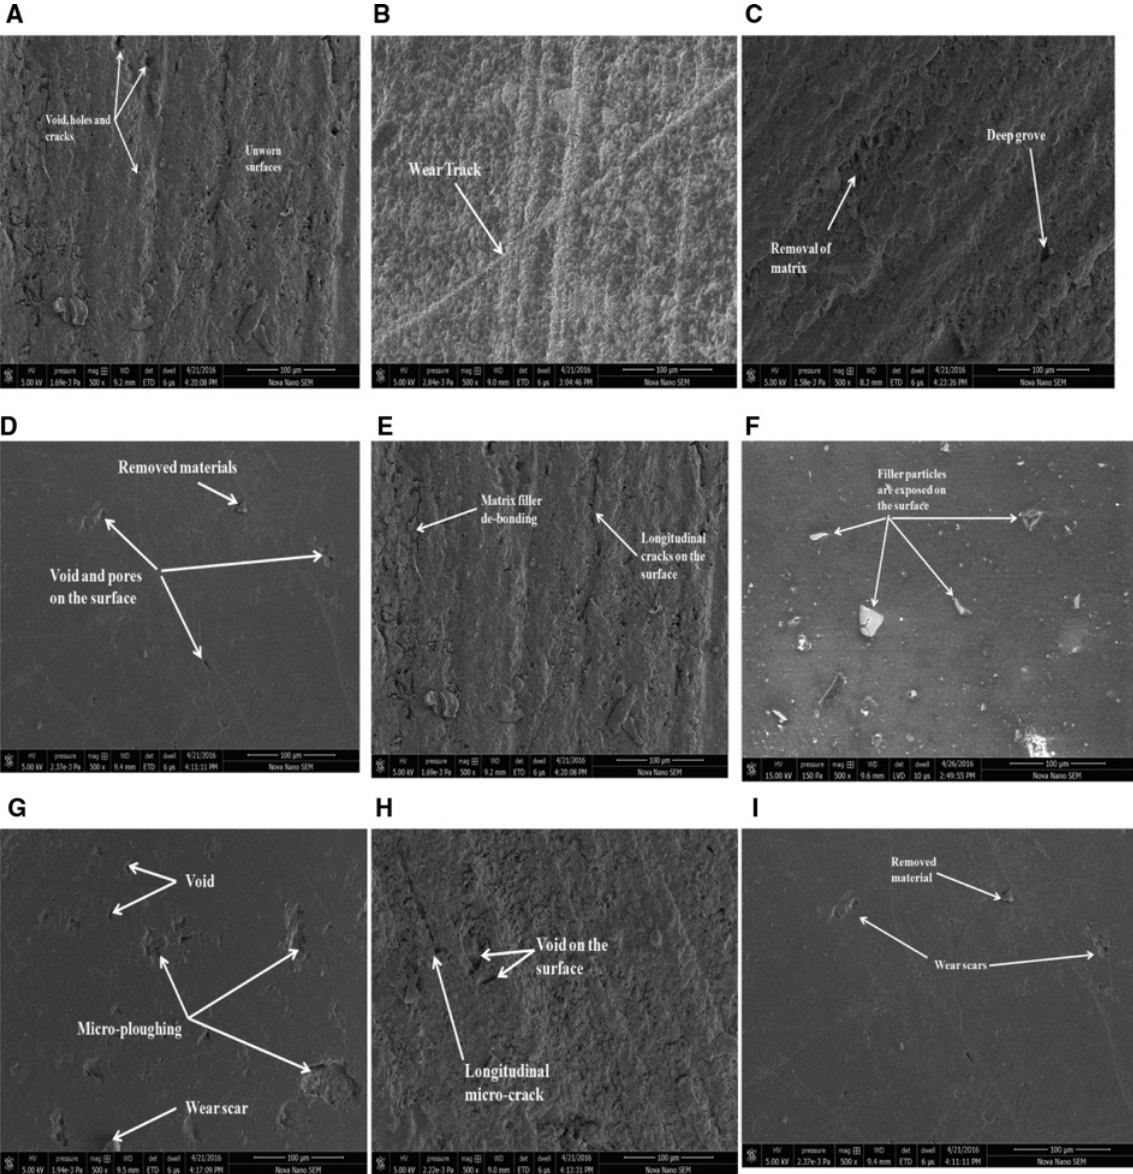
Figure 13: SEM of unworn and worn dental composites under steady state condition. (A) Dental composite DCMD-20 before wear test, (B) DCMD-20 at normal load 20 N (sliding speed at 5 mm/s and number of cycles at 8000), (C) DCMD-20 at normal load 100 N (sliding speed at 5 mm/s and number of cycles at 8000), (D) DCMD-20 at sliding speed 2.5 mm/s (normal load 40 N and number of cycles at 8000), (E) DCMD-20 at sliding speed 12.5 mm/s (normal load 40 N and number of cycles at 8000), (F) DCMD-20 at number of cycles 4000 (sliding speed 2.5 mm/s and normal load 40 N), (G) DCMD-20 at number of cycles 20,000 (sliding speed 2.5 mm/s and normal load 40 N), (H) DCMD-0 at (normal load 40 N, sliding speed at 5 mm/s and number of cycles at 8000, (I) DCMD-10 at 40 N ((normal load 40 N, sliding speed at 5 mm/s and number of cycles at